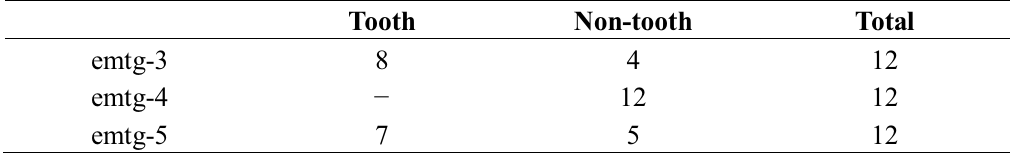
Table 4. Cont. Tooth